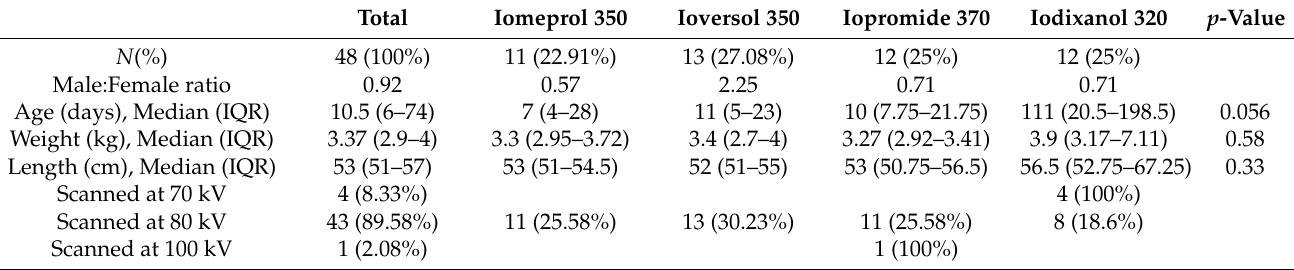
Table 1. Patient characteristics and tube